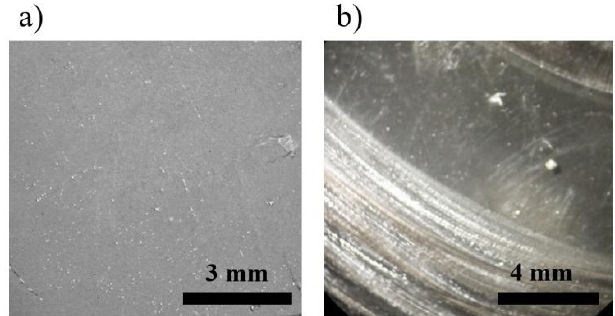
Figure 7. Microscopic images from the backside of the GaN crystals separated from sapphire substrate grown on an in-situ etched seed ( a ), grown on untreated seed, and separated by thermomechanical action ( b